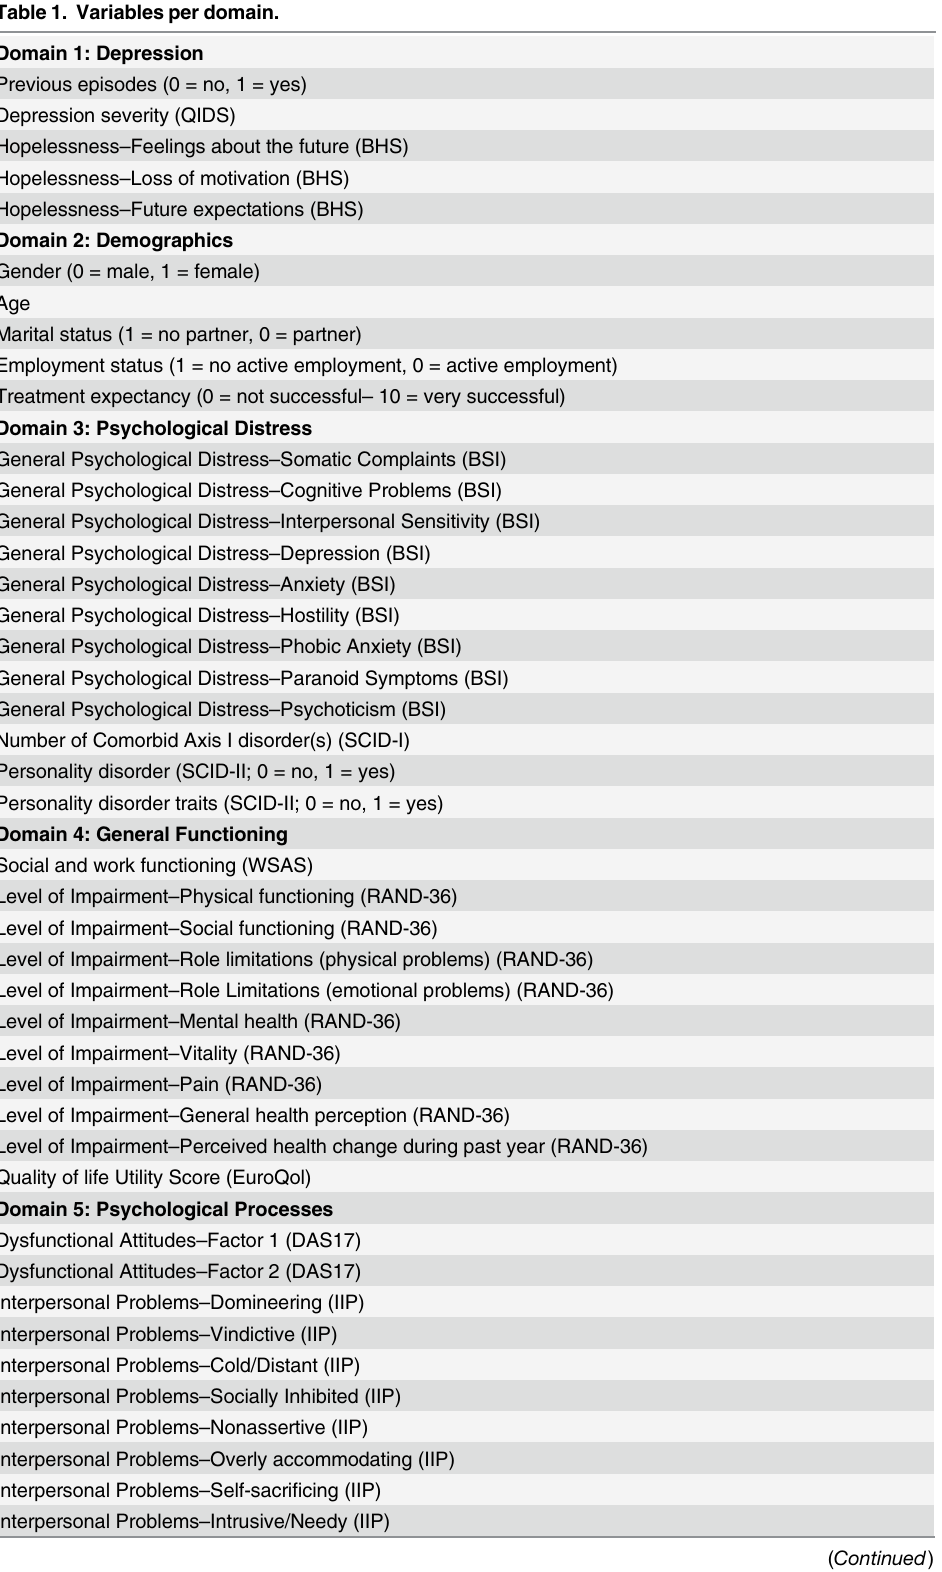
Table 1. Variables per